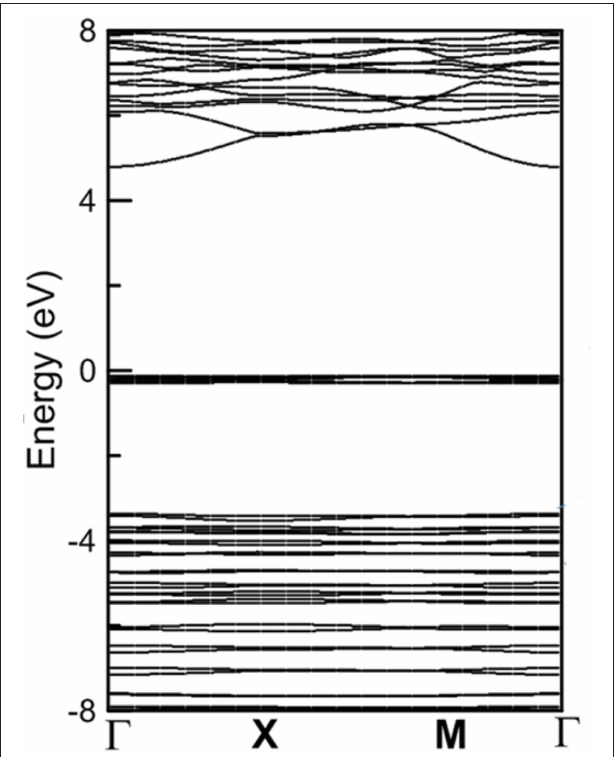
FIGURE 3 | The band structure of α − DIPAB